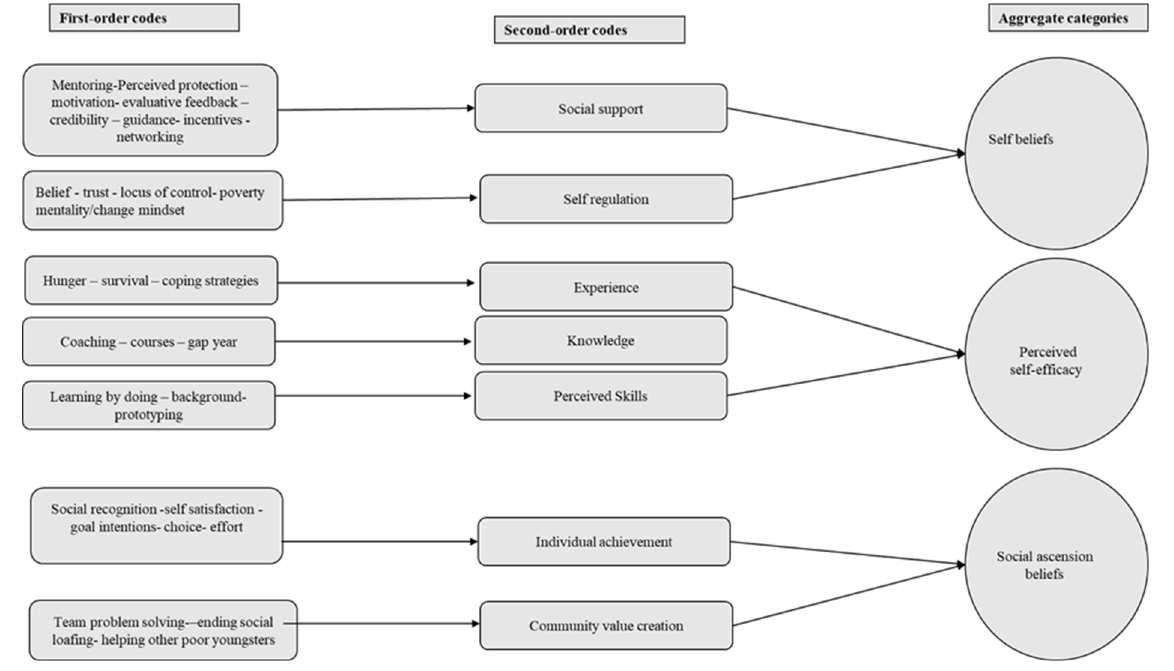
Figure 2. Data structure.